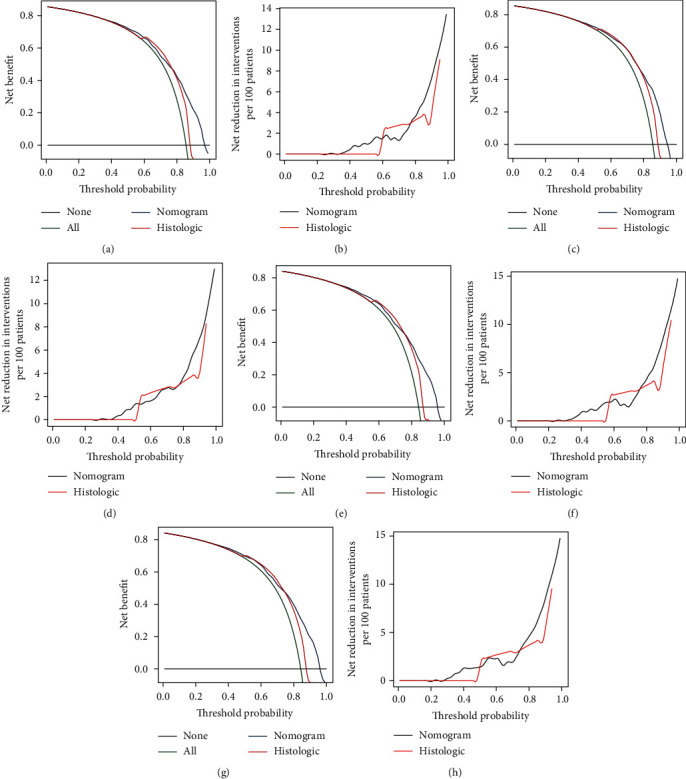
Decision curve analysis for the nomograms and histologic type of training set. Figure (a) and (c) are the new benefit curves of 3- and 5-year OS rates of training set. Figures (b) and (d) are the net reduction for intervention curves of the 3- and 5-year OS rates of the training set. Figure (e) and (g) are the new benefit curves of 3- and 5-year CSS rates of training set. Figures (f) and (h) are the net reduction for intervention curves of the 3- and 5-year CSS rates of the training set.